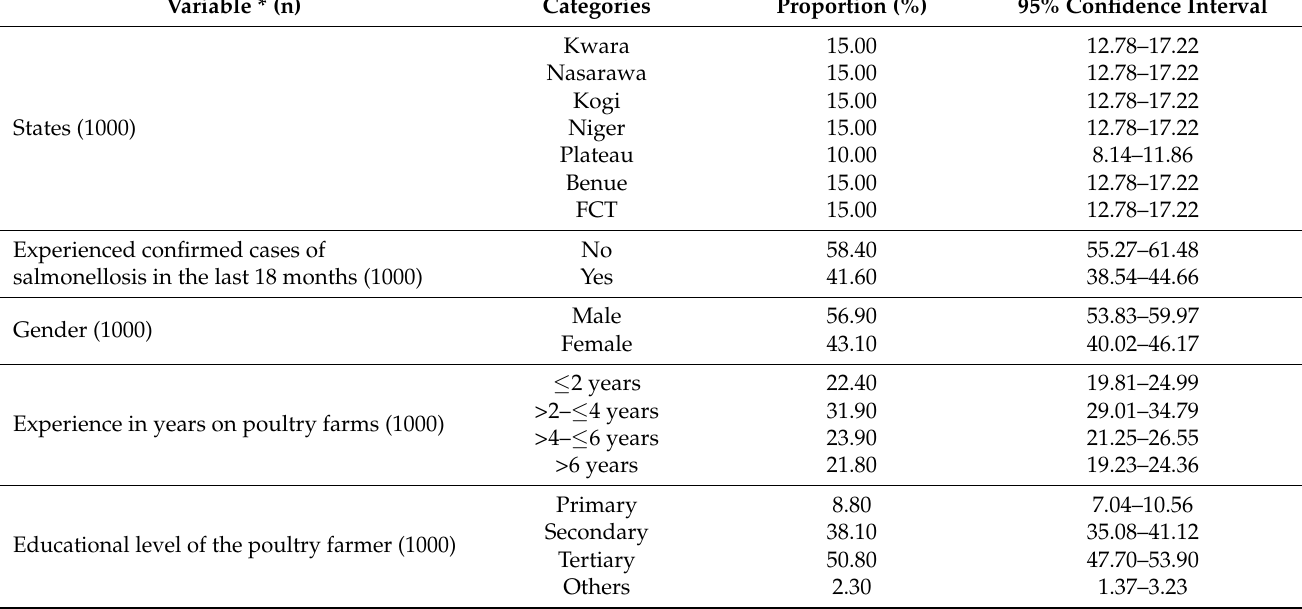
Table 2. Descriptive analysis of the respondents’ variables for the incidence of non-typhoidal Sal- monella in poultry farms, North Central Nigeria.